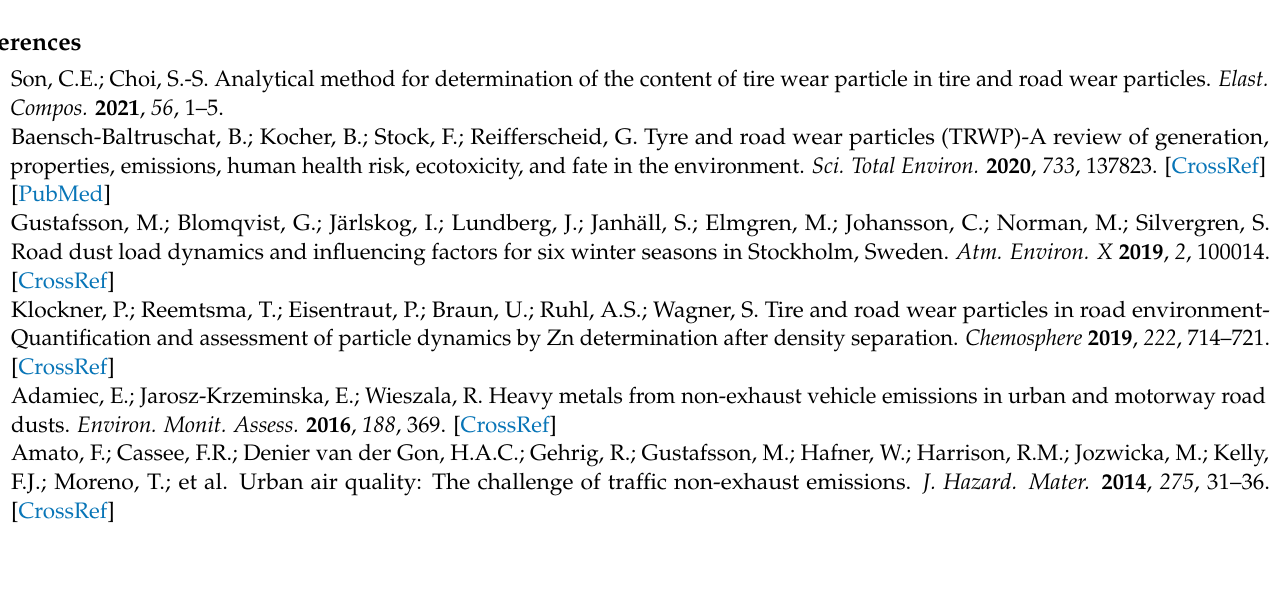
TRW; Figure S2. SEM images of the real MPs of 212–500 µ m collected at the bus sto; Figure S3. SEM images of the chloroform-treated real TRWPs of 212–500 µ m collected at a bus stop; Figure S4. SEM images of the model TRWPs made of TWPs without treatment by the single step pressing procedure; Figure S5. SEM images of the model TRWPs made of TWPs without treatment by the double step pressing procedure; Figure S6. TGA thermogram of the model TWP; Figure S7. TGA thermograms of the model TRWPs made of TWPs without treatment by the single (a) and double (b) step pressing procedures; Figure S8. SEM images of the untreated and chloroform-treated TWPs; Figure S9. SEM images of the model TRWPs made of the chloroform-treated TWPs by the single step pressing procedure; Figure S10. SEM images of the model asphalt pavement wear particles of 20–38 µ m; Figure S11. SEM images of the model TRWPs made of the untreated TWPs (212–500 µ m) and the asphalt pavement wear particles (20–38 µ m); Figure S12. Preparation process of tailor-made TRWPs; Figure S13. SEM images of various TWPs made by cryogenic crushing. The NR_C35, NR_C55, and NR_C75 samples are NR = 100 vulcanizates with carbon black con- tents of 35, 55, and 75 phr, respectively. The NRBR_C35, NRBR_C55, and NRBR_C75 samples are NR/BR = 80/20 vulcanizates with carbon black contents of 35, 55, and 75 phr, respectively; Figure S14. Photographs of preparation of TWPs using a hand drill and a tensile test specimen, and SEM images of the various SBR TWPs made using the hand drill method; Figure S15. SEM images of the model concrete pavement (CPP1 and CPP2) and stone (SP1 and SP2) wear particles of 20–38 µ m; Table S1. Formulation of the model TWP (phr); Table S2. EDS analysis results of the real MPs of 212–500 µ m (rMP1, rMP2, and rMP3) and the chloroform-treated TRWPs of 212–500 µ m (rTRWP1 and rTRWP2) collected on the road; Table S3. EDS analysis results of the model asphalt pavement wear particles (APP1 and APP2), the model concrete pavement wear particles (CPP1 and CPP2), and the model stone wear particles (SP1 and SP2) of 20–38 µ